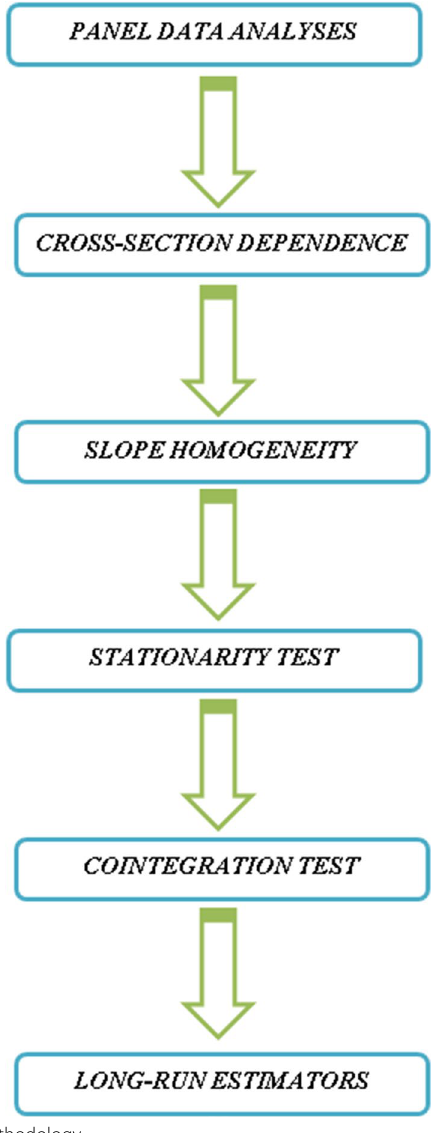
Fig. 1 The steps of the methodology